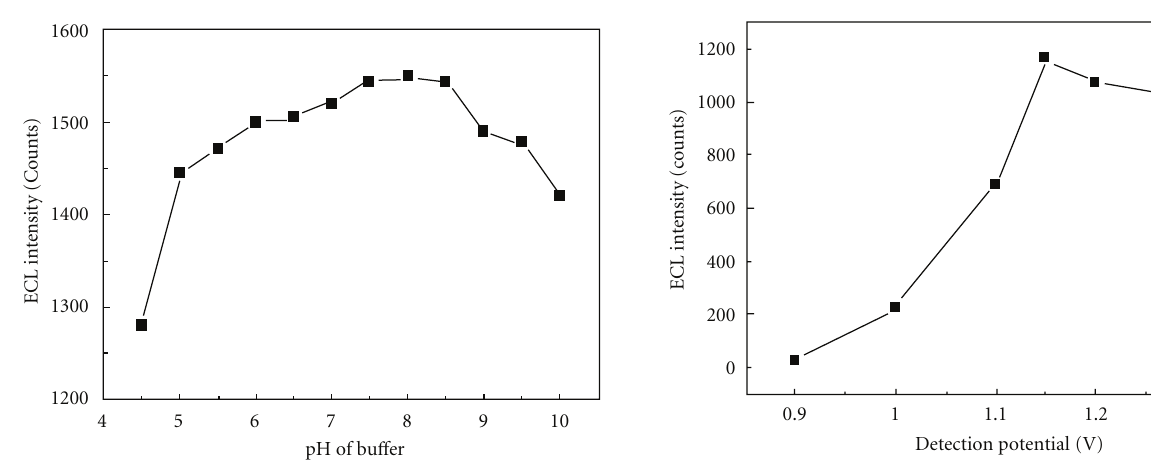
Figure 4: pH e ff ect of running bu ff er on ECL intensity: other conditions, the same as in Figure3.